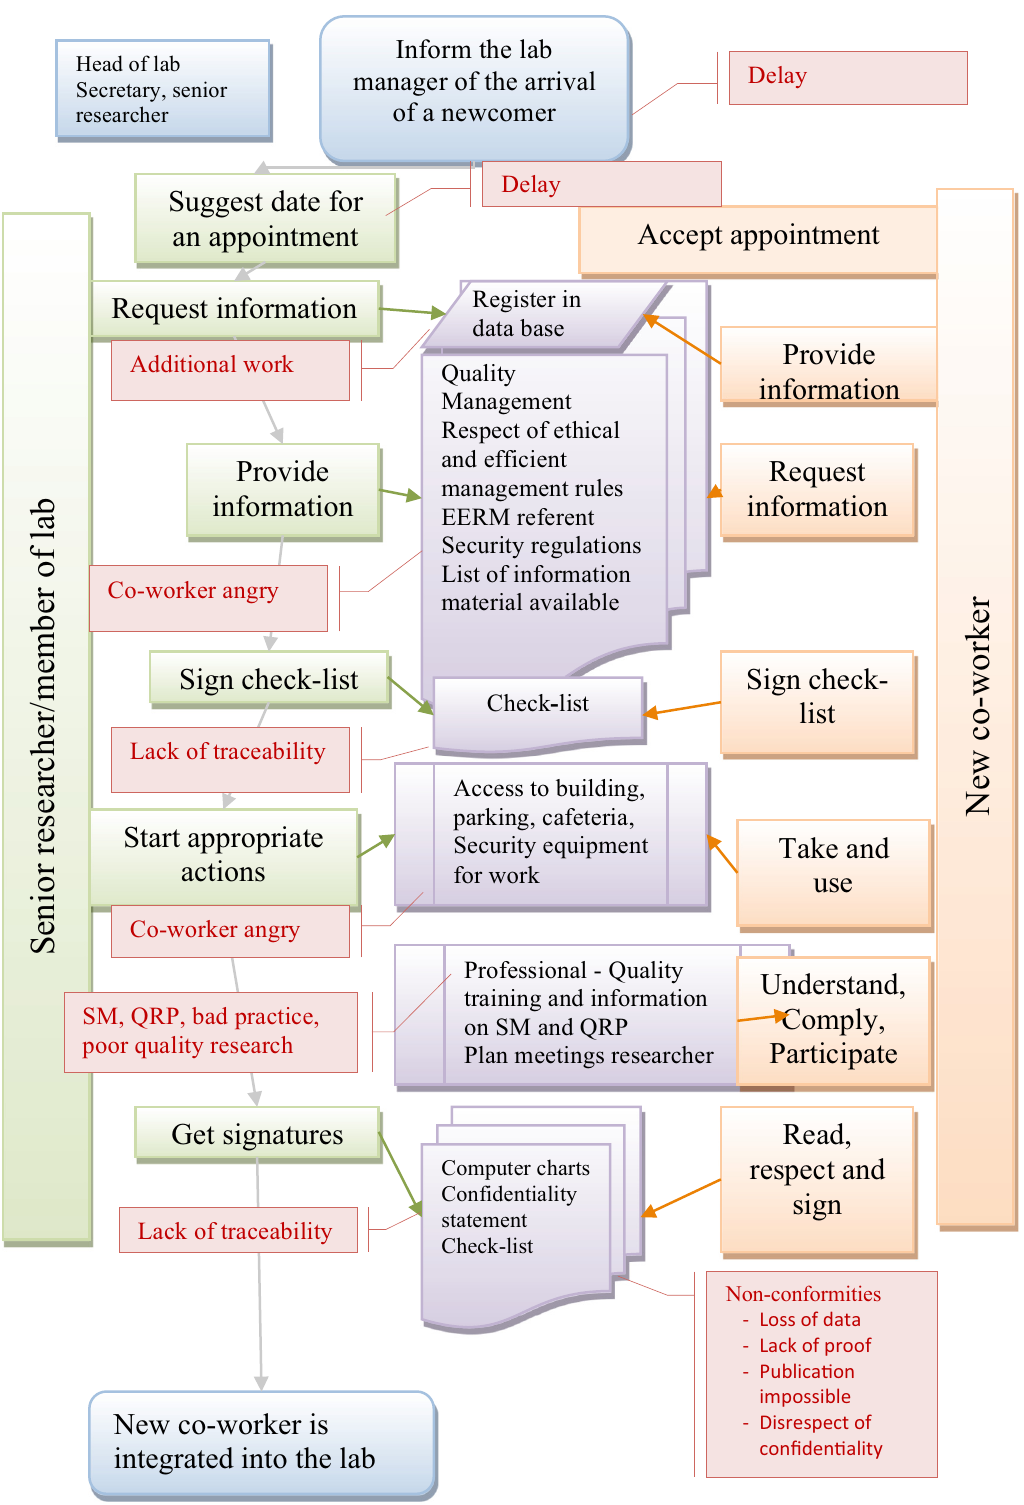
Fig. 3. Arrival of a new co-worker: fl ow-chart with risky steps (indicated in